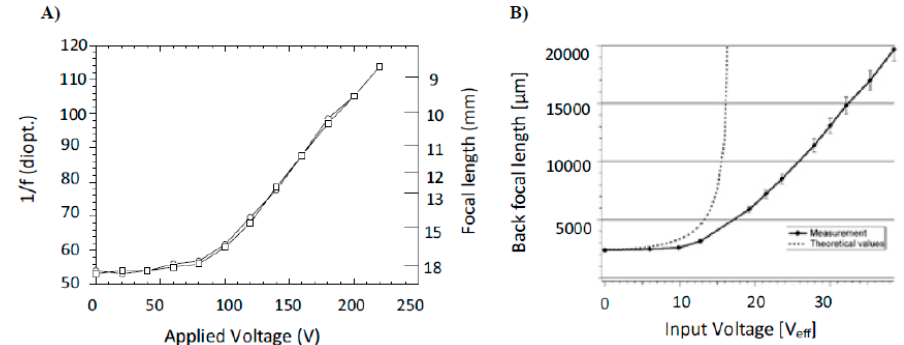
Figure 5. ( A ) Variation in focal length (in mm) and power of lens (inverse of focal length) with the applied voltage. The two curves superimpose as the voltage is increased and decreased, respectively.